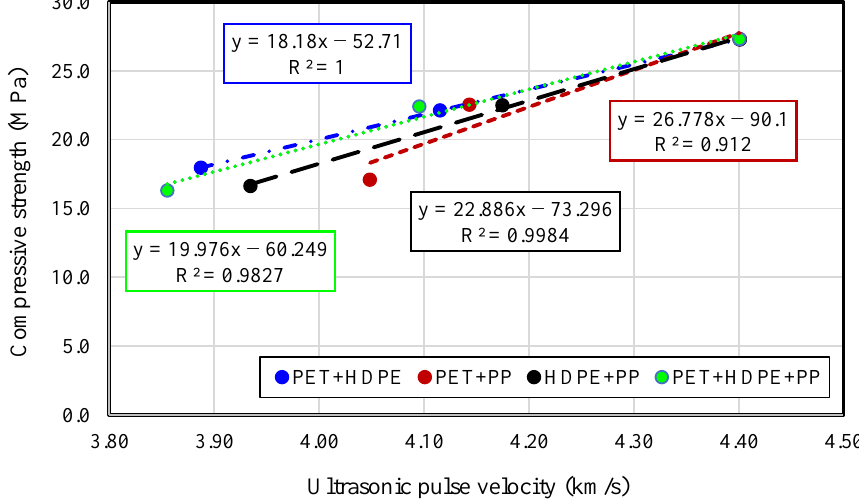
Figure 24. Variation of ultrasonic pulse velocity with different combinations of recycled plastic aggregates.